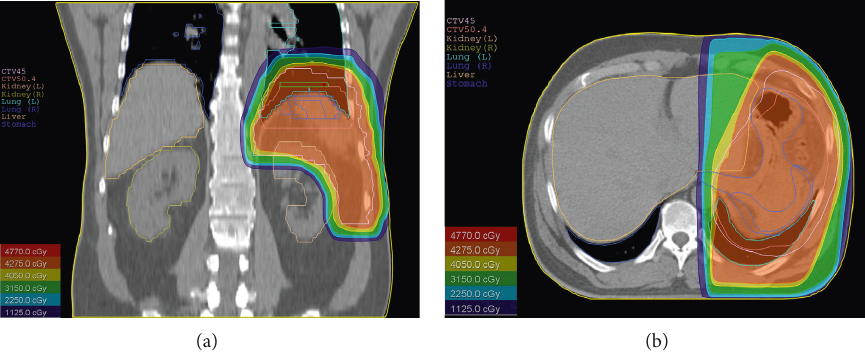
Figure 6: The coronal scope (a) and axial scope (b) of radiotherapy plan and dose distribution illustrated by different